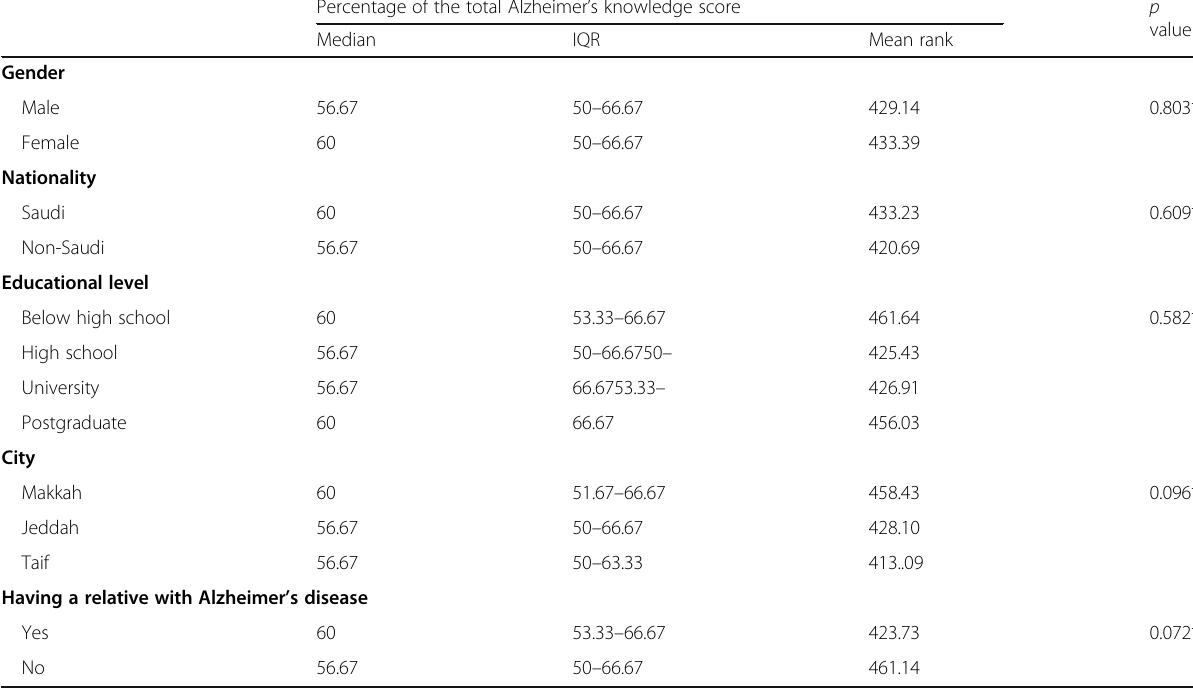
Table 3 Factors associated with percentage of the total Alzheimer ’ s knowledge score among the participants Percentage of the total Alzheimer ’ s knowledge